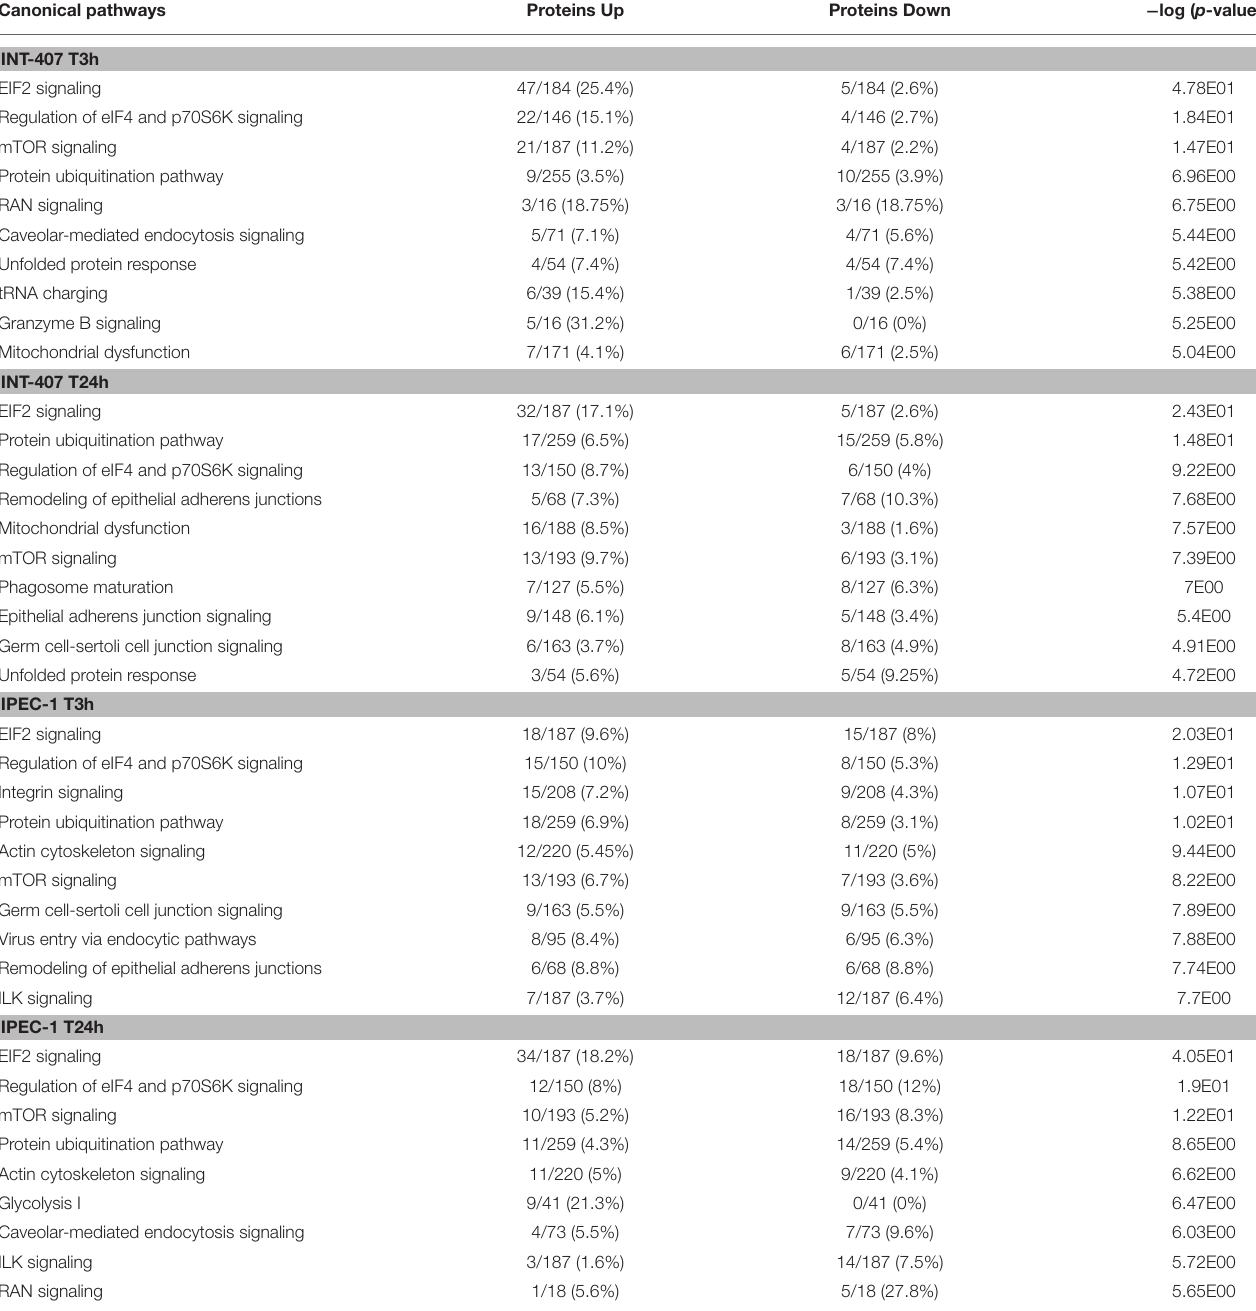
TABLE 1 | The top 10 canonical pathways induced by Campylobacter jejuni in INT-407 and IPEC-1 cells at 3 and 24h post-infection. Canonical pathways Proteins